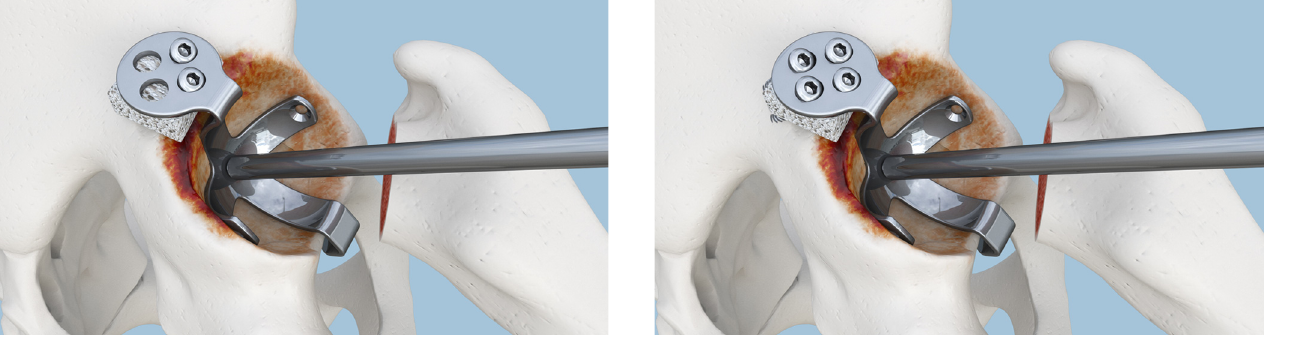
Figure 8. Fixation of the palette to the graft and iliac bone. Figure 10. Fixation completed. Upper view.